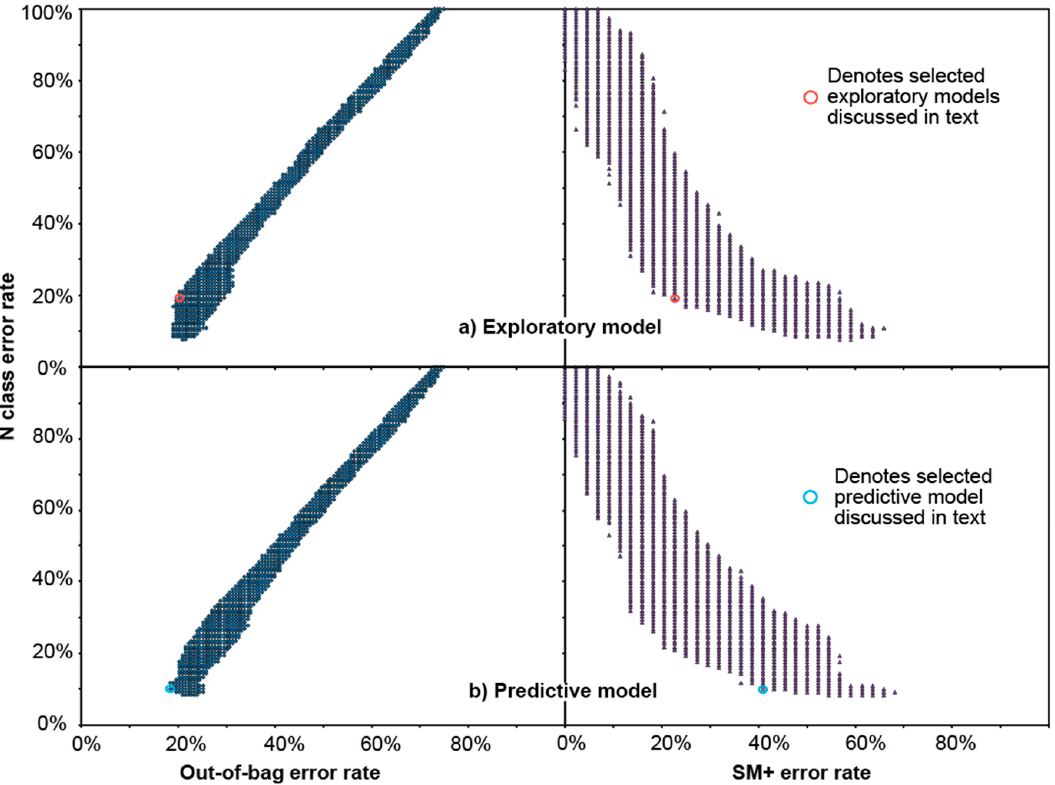
Figure 3. Results of ~900,000 optimization runs of ( a ) exploratory and ( b ) predictive random forests models for select argument values to minimize N class error rate while maintaining a low overall OOB error rate. Note most results overlap visible points in charts.